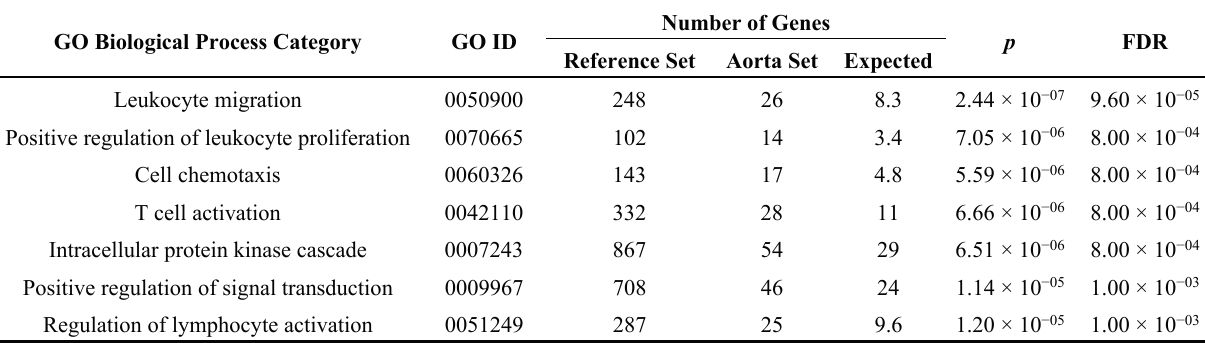
categories, and Table S7 for a list of the genes in the aorta set in each category. Table 9. Enriched GO biological process categories for the target genes identified in AAA ChIP-chip with a combined analysis of transcription factors RUNX1, STAT5 and